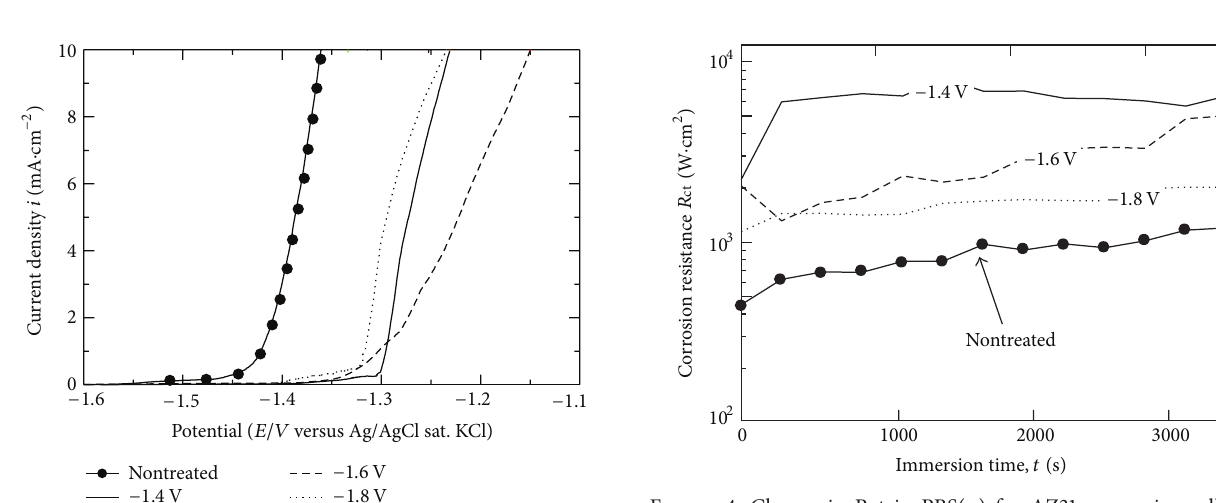
Figure 4: Change in Rct in PBS( − ) for AZ31 magnesium alloys before and after treatment at − 1.4V, − 1.6V, and −